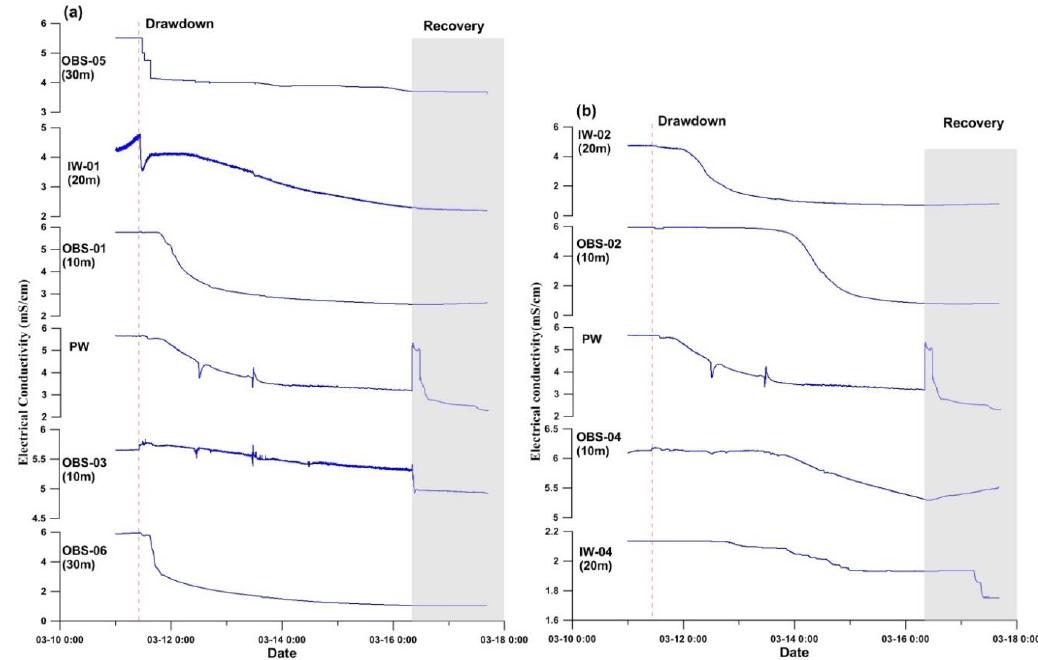
Figure 9. Changes in EC values at 25-m depth along the cross-sections ( a ) A-A’ and ( b ) B-B’ during drawdown and recovery. The numbers in parentheses refer to the distance from the pumping well.